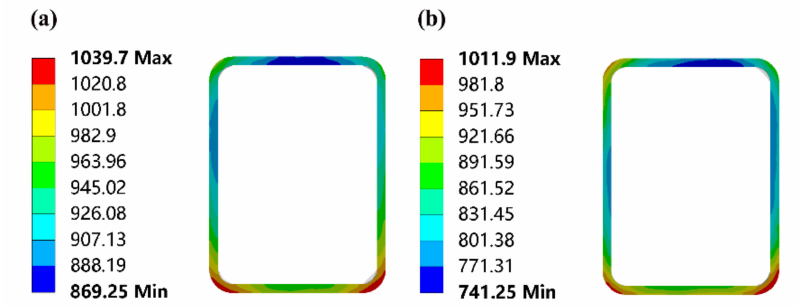
Figure 12. The temperature distribution in the middle section of the rectangular steel tube: ( a ) the inductor with the structure c; ( b ) the inductor with the structure d.